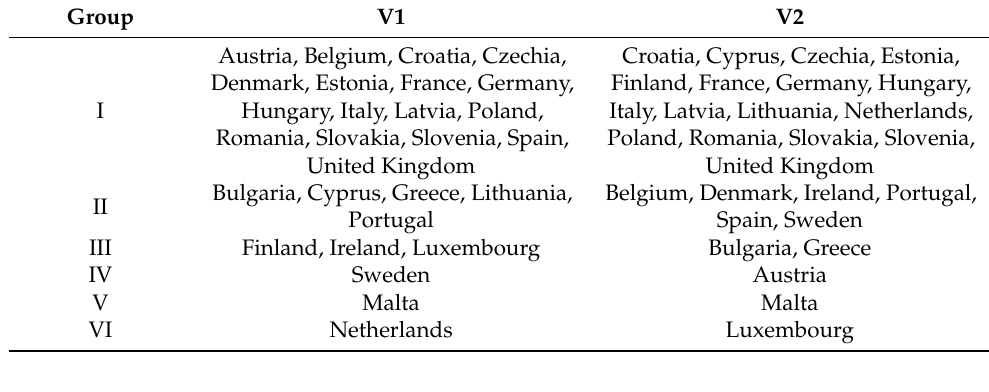
Table 6. Division of EU countries into typological groups in 2018—variants: V1 and V2. Group V1 V2